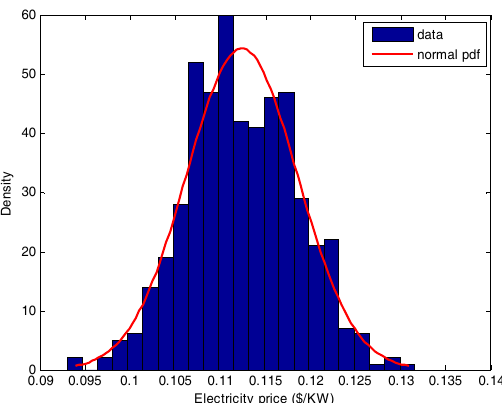
Figure 4. PDF of the electricity price.